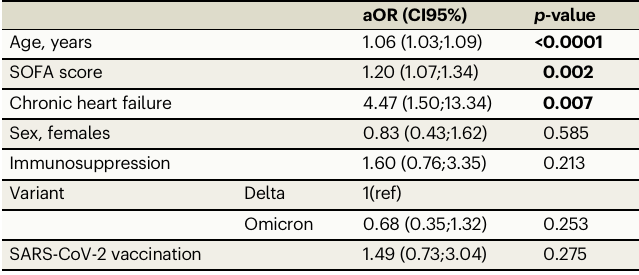
Table3| Independent predictors ofday-28 mortalityavailable within 24 h after ICU admission by multivariable logistic regression analysis in the 259 patients with Omicron or Delta